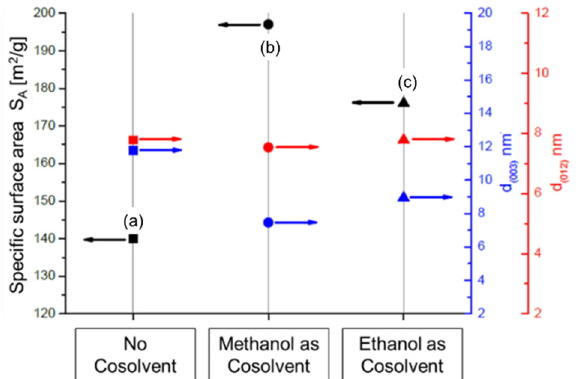
Figure 7. Specific surface area and crystallite sizes depending on the cosolvent used for the hydrolysis reaction. Synthesis conditions: c[alkoxide] = 0.17 mol · L − 1 , T hydro = 298 K, n [(NH 4 ) 2 CO 3 ]/n[M 3+ ] = 1, n [H 2 O]/n[M] = 50.